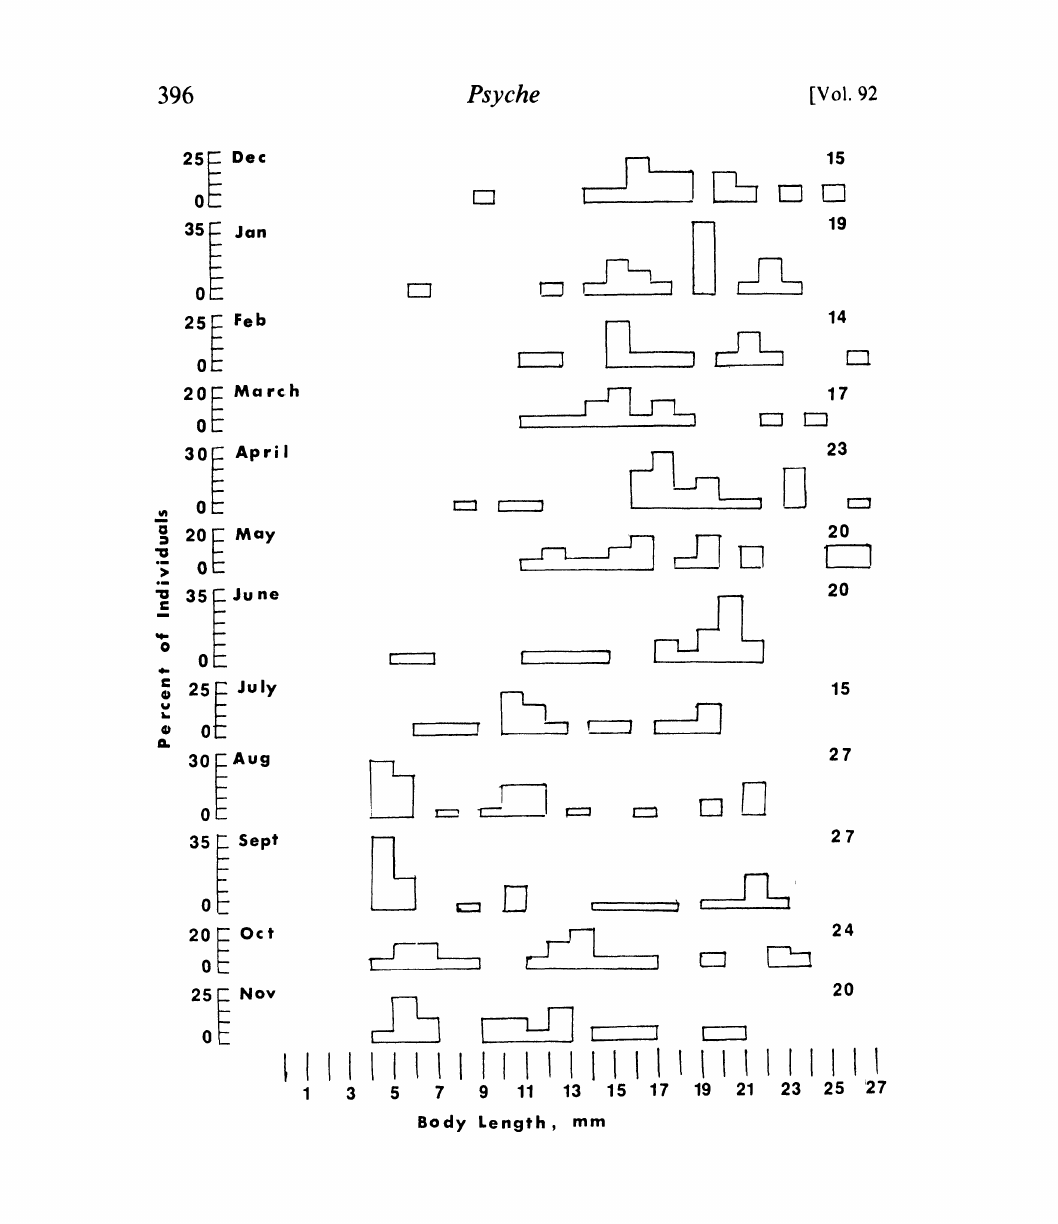
Figure 1. Length-frequency histograms showing monthly distribution of Acro- neuria carolinensis